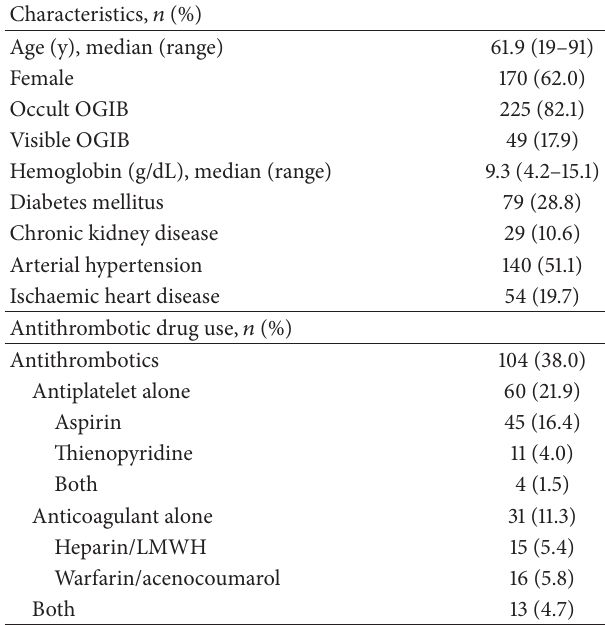
Table 1: Baseline patients’ characteristics and antithrombotic